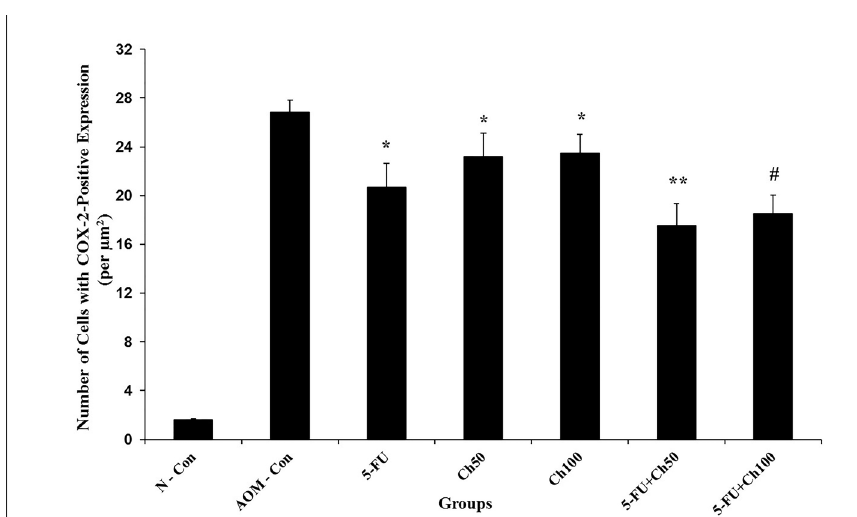
FIGURE 5 - Effects of Chrysin 50 mg/kg (Chr50), Chrysin 100 mg/kg (Chr100), 5-FU, and their combinations on the expression of cyclooxygenase-2 (Cox-2) protein in AOM-induced mice colorectal tumors (n=6). * p <0.01versus AOM-Con; ** p <0.001versus AOM – Con, Ch50, Ch100 and p <0.05 versus 5-FU; # p <0.001 versus Aom-Con, Ch50,